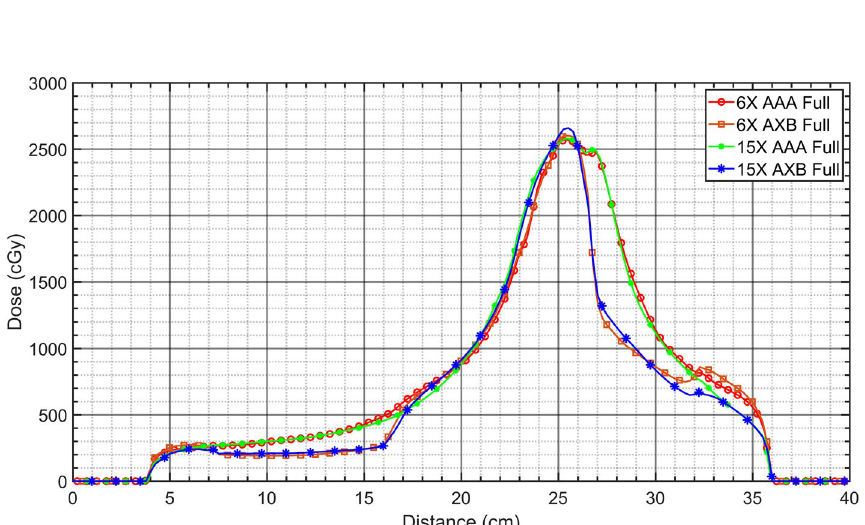
Figure 6. Comparison of dose profiles at the center of the PTV in the full arcs-based VMAT plans with different energies and caluation